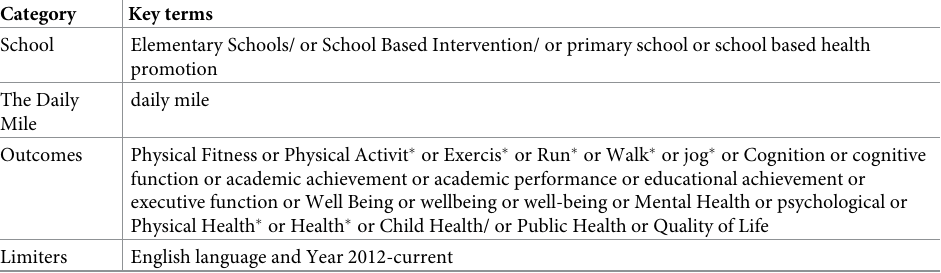
Table 1. Search terms used in PsycINFO search (adapted for the other